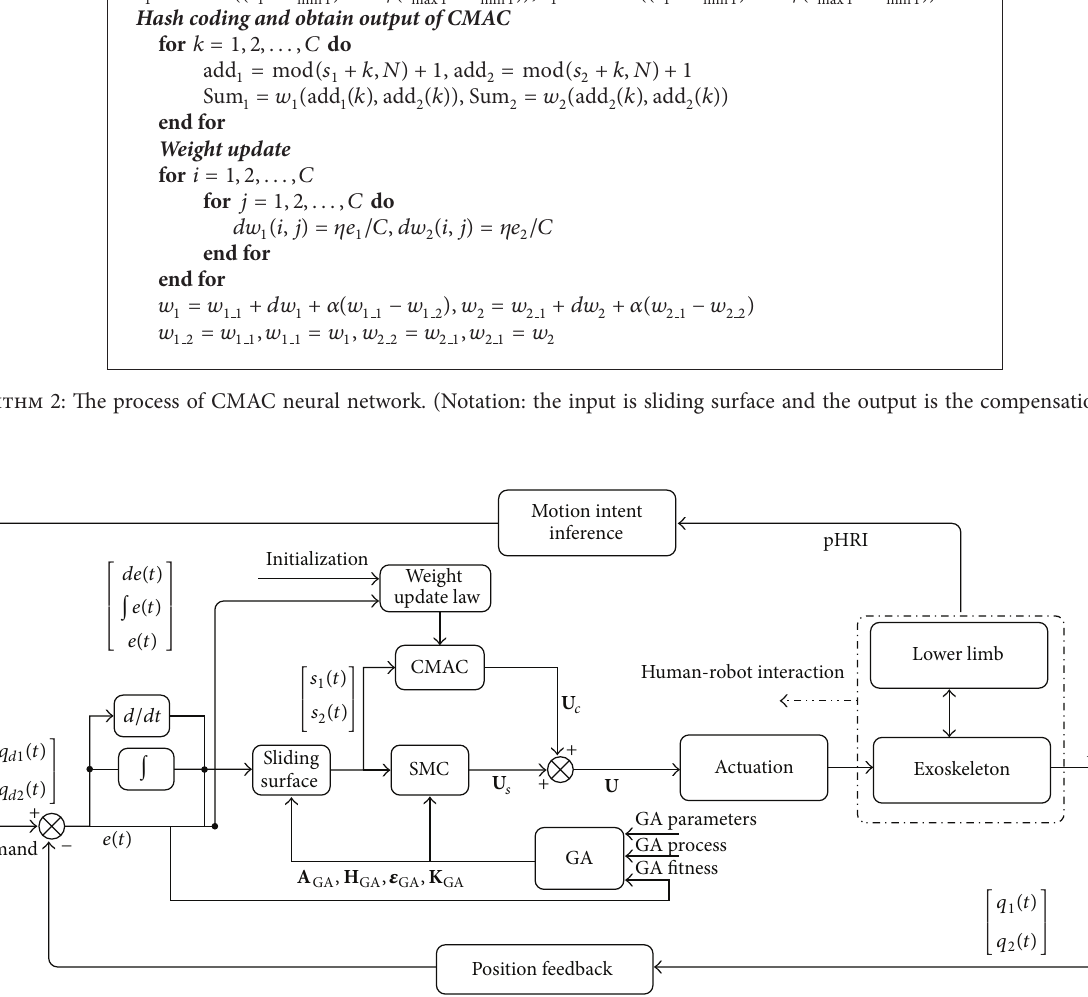
Figure 4: The control diagram of the proposed method for the exoskeleton